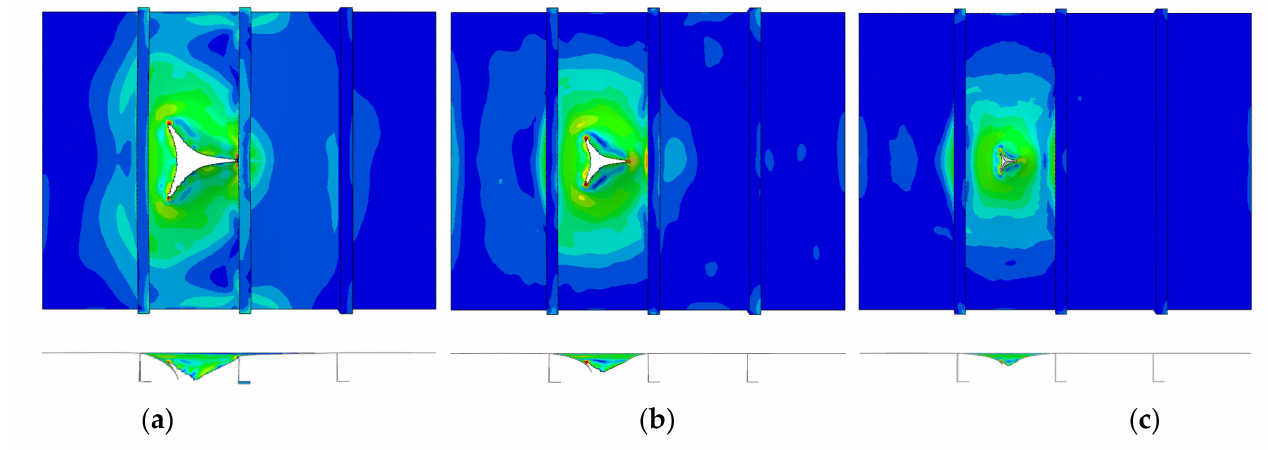
Figure 9. Damage mode of the three specimens in the numerical simulation: ( a ) 1:4 scaled; ( b ) 1:2 scaled; ( c )